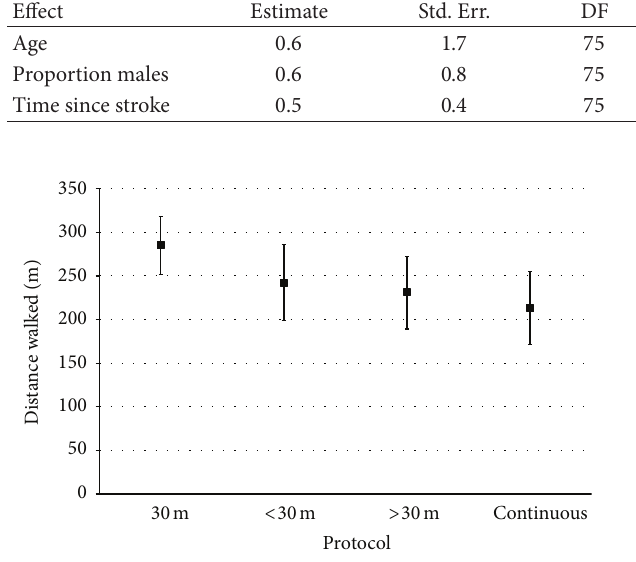
Figure 2: Distances achieved (point estimate, 95% CI) during the 6MWT based on walkway protocol